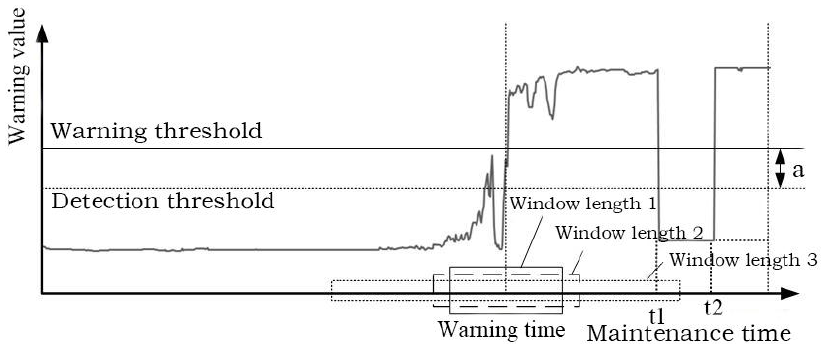
Figure 4. False alarm analysis chart.